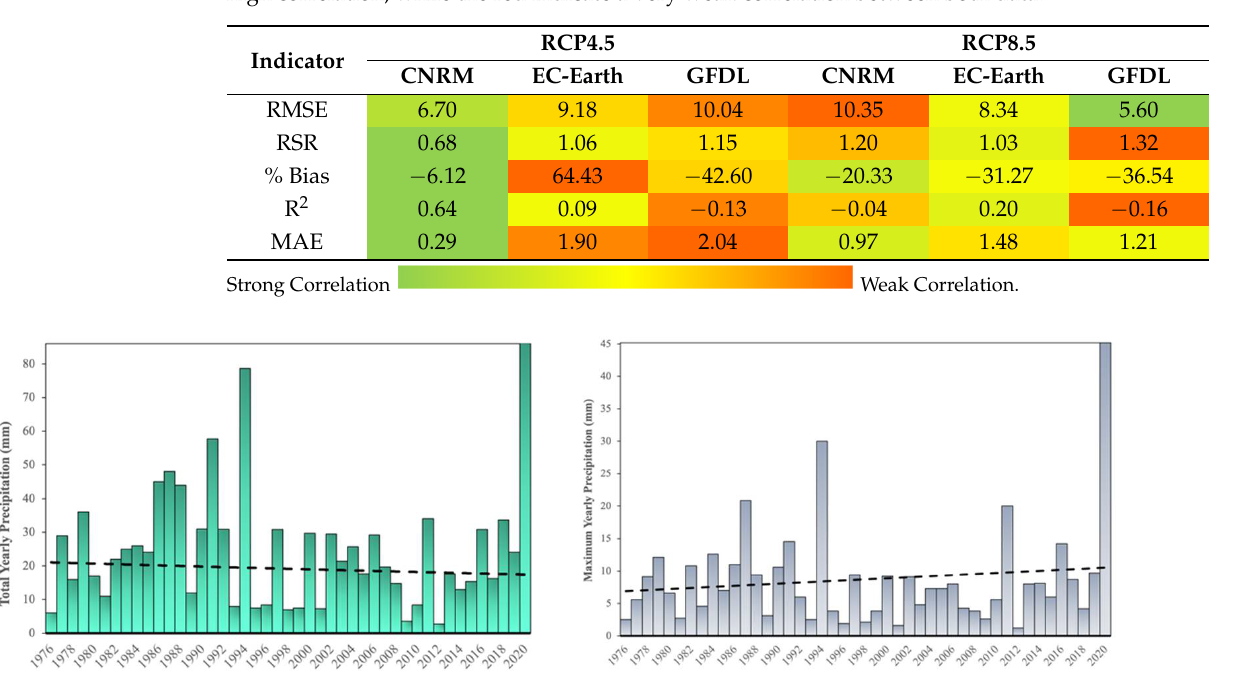
Table 6. Results of the comparison between climate change projection models and ground measured rainfall data using six statistical indicators. The results are color coded where the green indicate a high correlation, while the red indicate a very weak correlation between both data.